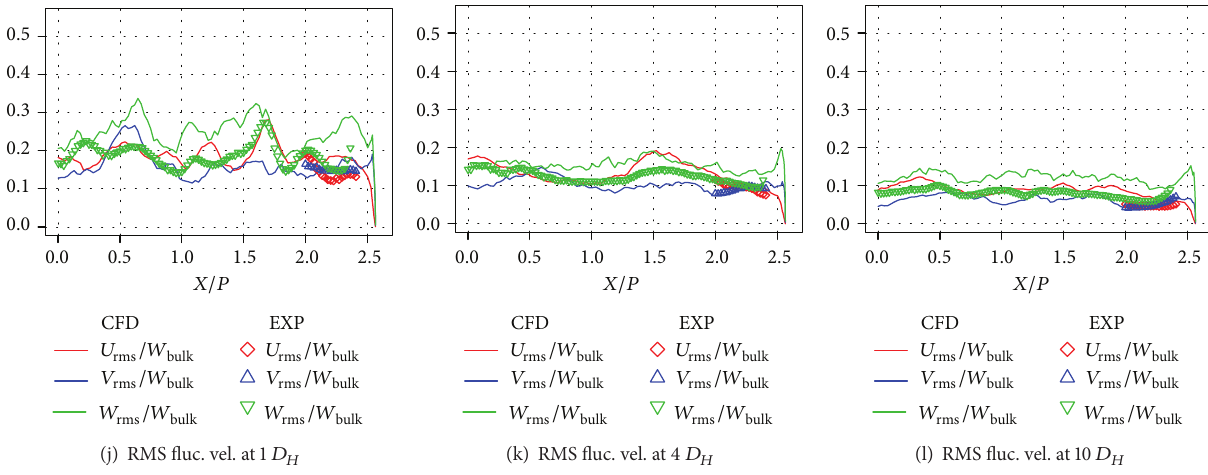
Figure 16: Mean and RMS velocity components at 𝑦 elevation for split spacer-grid type. The horizontal axis represents normalized distance wall from the center of the channel to the wall, while the vertical represents normalized velocities or RMS fluctuations.